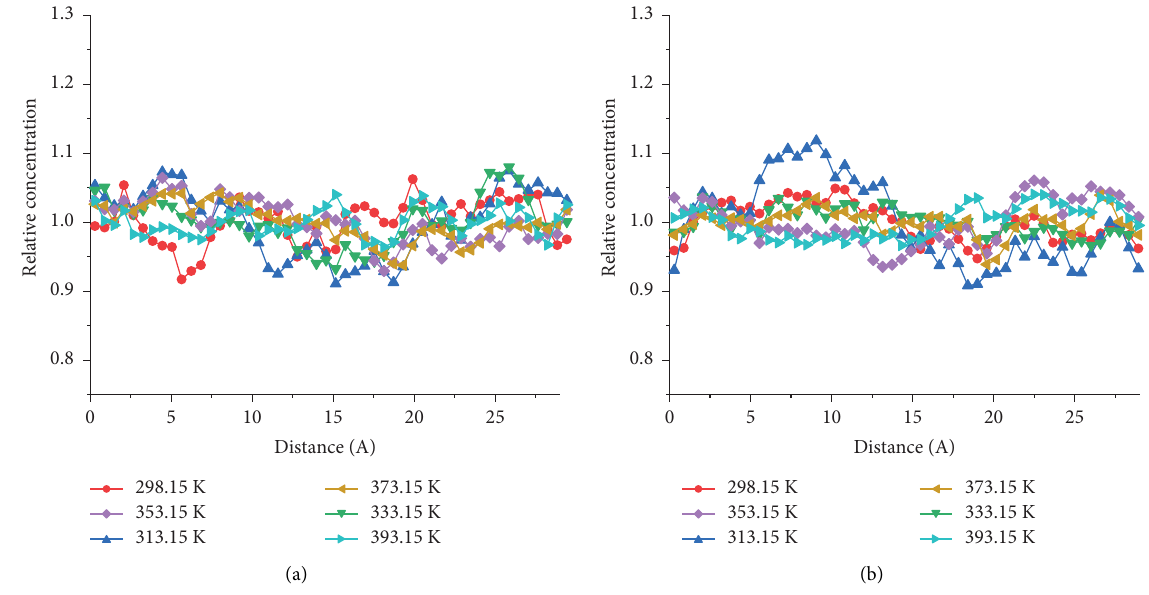
Figure 11: Relative concentration distribution of Fe 2 O 3 -asphalt model (a) and SiO 2 -asphalt model (b) in the OY